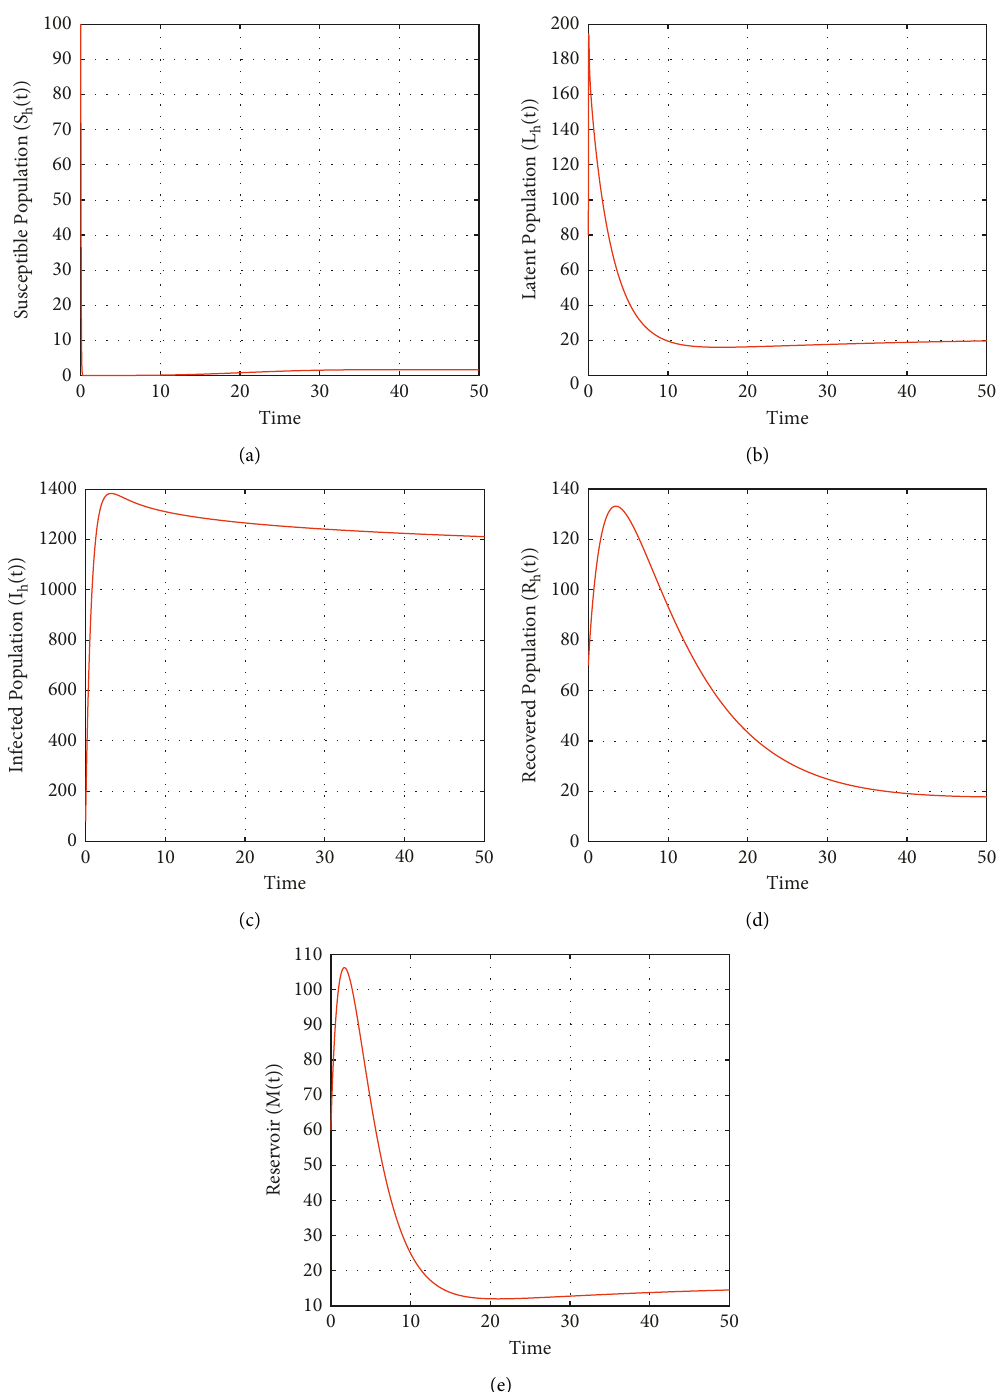
Figure 3: The results visualizes the dynamics of the proposed model at endemic state ( X ) , where the value of the epidemic parameters are: 2 � 0 . 11, β � 0 . 00005, β � 0 . 1, d � 0 . 1, c � 0 . 001, c � 0 . 2, c � 0 . 3, d � 0 . 2, η � 0 . 3, η � 0 . 5, and α � 0 . 4. In this case, the Λ � 0 . 5, β 1 2 3 1 1 2 3 1 2 > 1. (a) Susceptible– S h ( t ) . (b) Latent– L h ( t ) . (c) Infected– I h ( t ) . (d) value of the reproductive number is greater than unity i.e., R 0 Recovered– R h ( t ) . (e) Reservoir– M ( t )